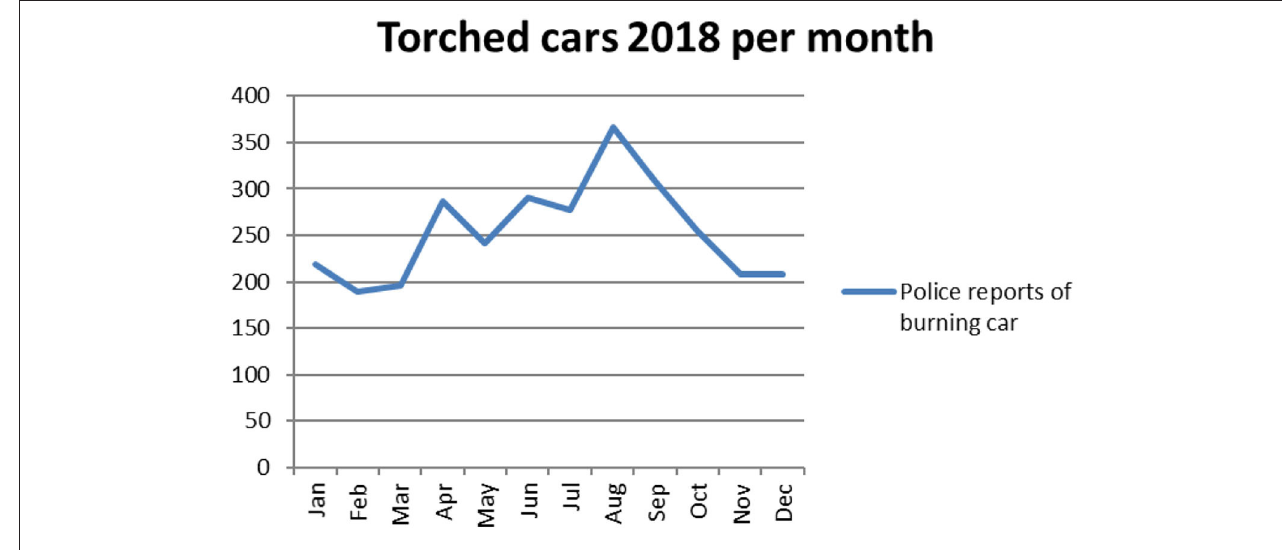
FIGURE 1 | Vehicle arsons per month in the year 2018.